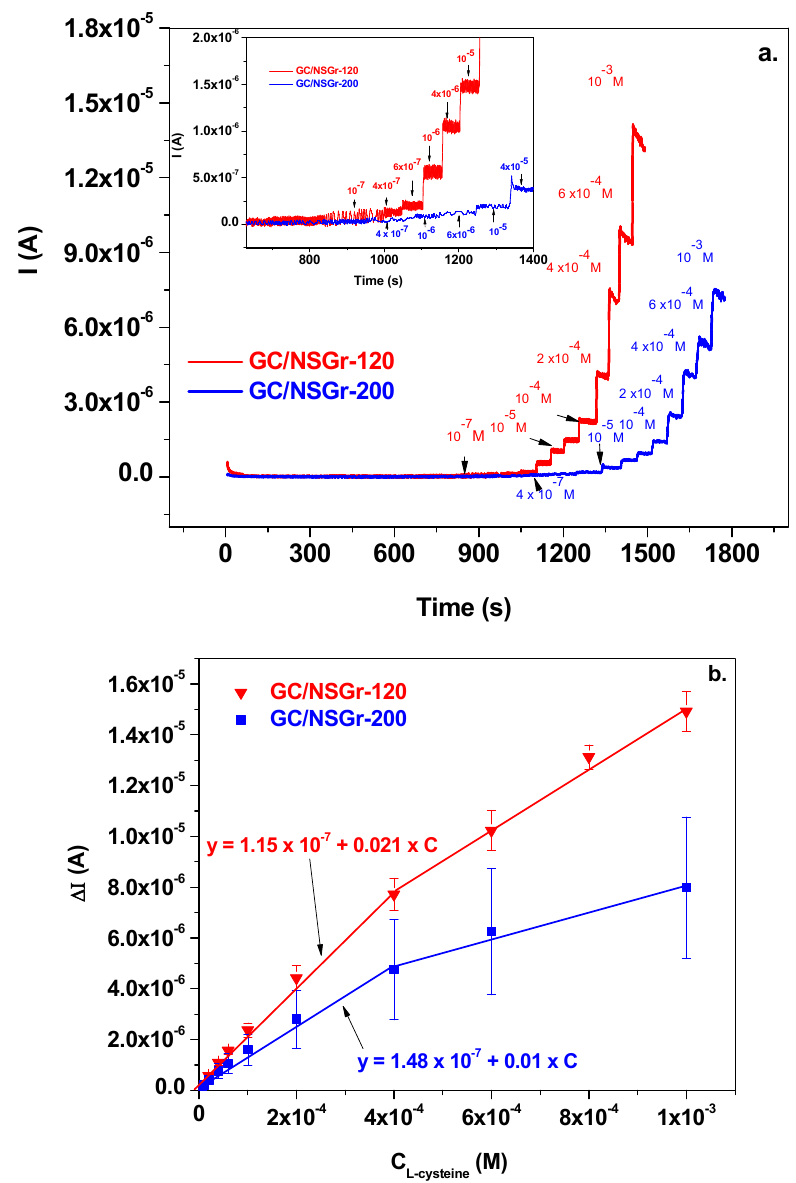
Figure 11. Amperometric curves recorded with GC/NSGr-120 (red) and GC/NSGr-200 (blue) electrodes in pH 6 PBS supporting electrolyte, after the addition of known concentrations of L-cysteine ( a ). The corresponding calibration plots showing mean value from 3 measurements: GC/NSGr-120 (red); GC/NSGr-200 (blue) ( b ).